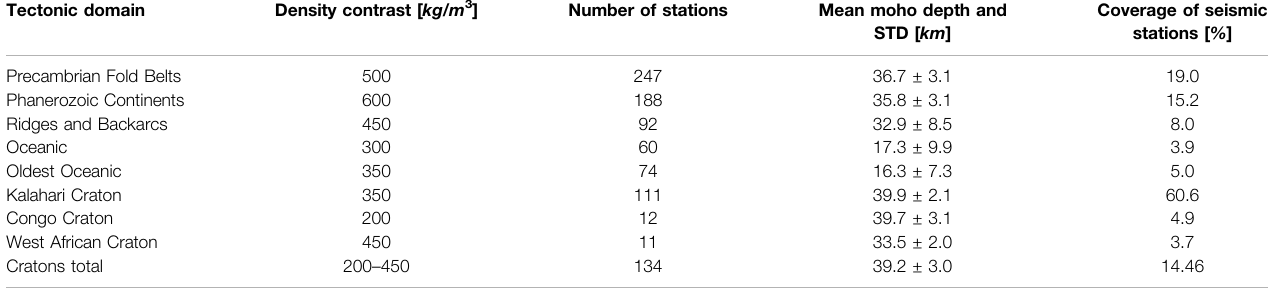
TABLE 1 | Estimated density contrasts and distribution of seismic stations. STD (cid:1) standard deviation. Tectonic domain Density contrast [ kg / m 3 ]